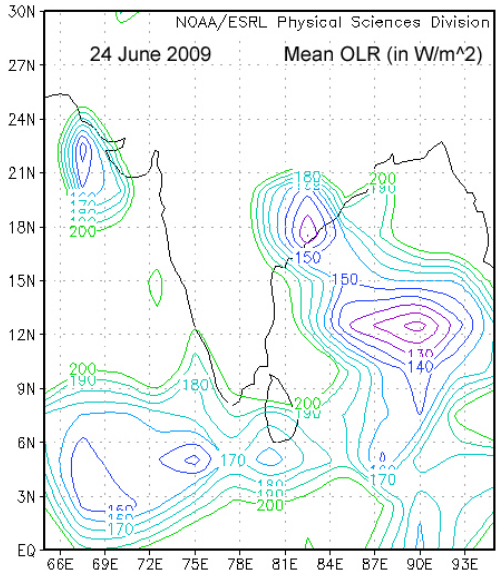
Figure 7. High-resolution infrared image of KALPANA-1 satellite for 24–25 June